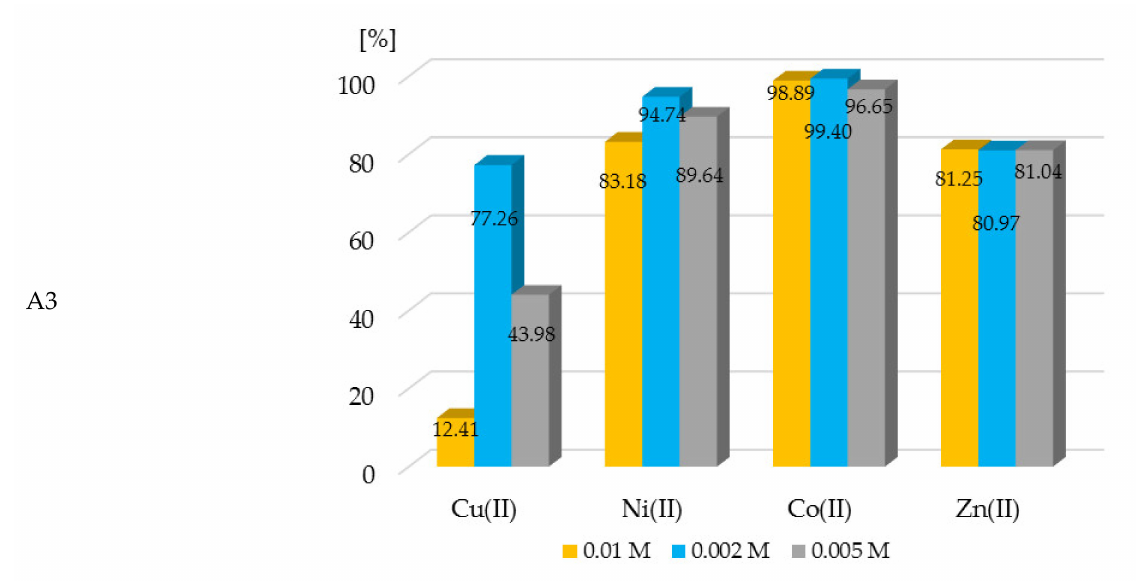
Figure 4. The dependence of the concentration of metal ions in aqueous solution on percent of extraction of metal ions with compounds A1–A3. The given values of the %E M carry ±